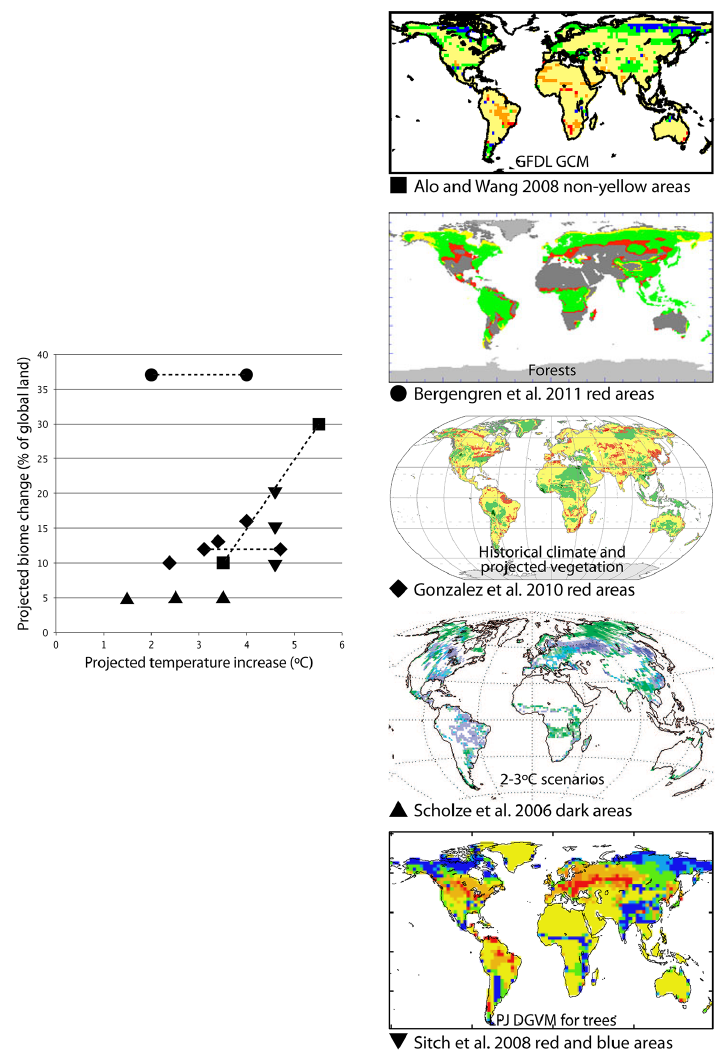
Figure 1. Projected changes in terrestrial ecosystems in previous studies. Right-hand panels show global maps of projected changes. Left- hand panel shows percentage of global land projected to undergo biome change in these studies, for different levels of increase in global mean